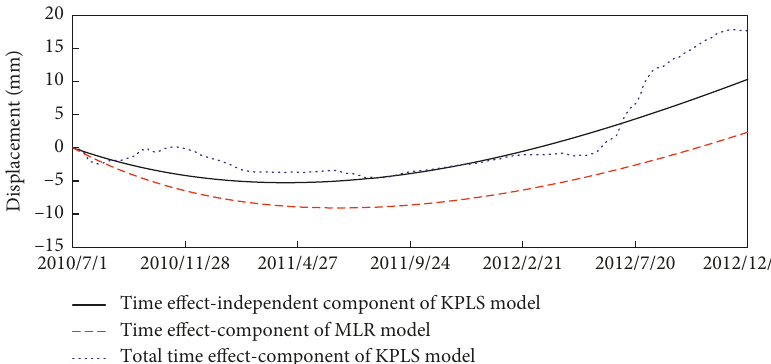
Figure 12: Comparison of time effect of models for radial displacement.